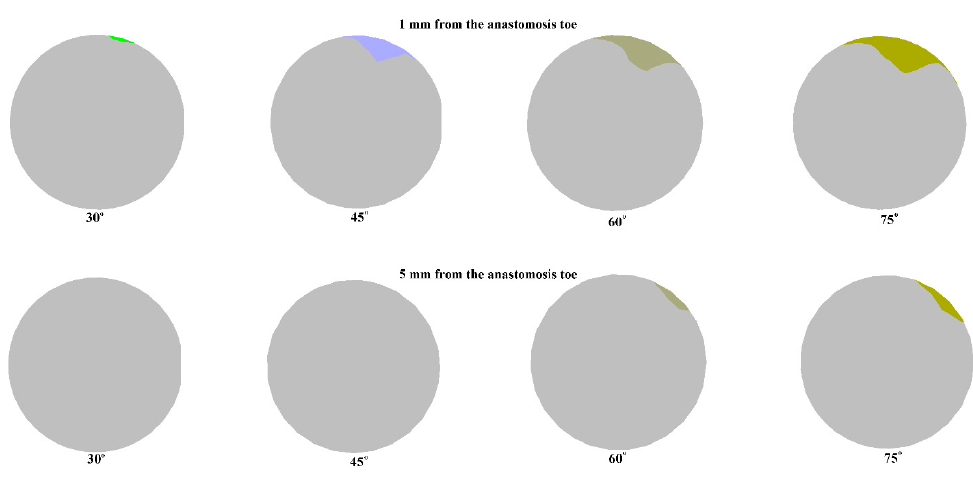
Figure 11. Areas a ff ected by recirculation 1 mm and 5 mm away from the anastomosis